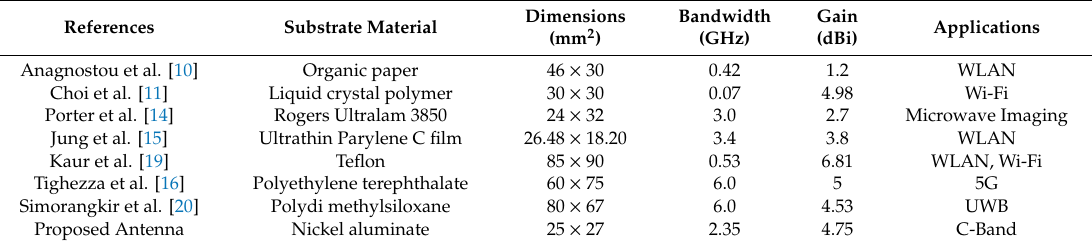
Table 5. Comparison between the proposed and existing material